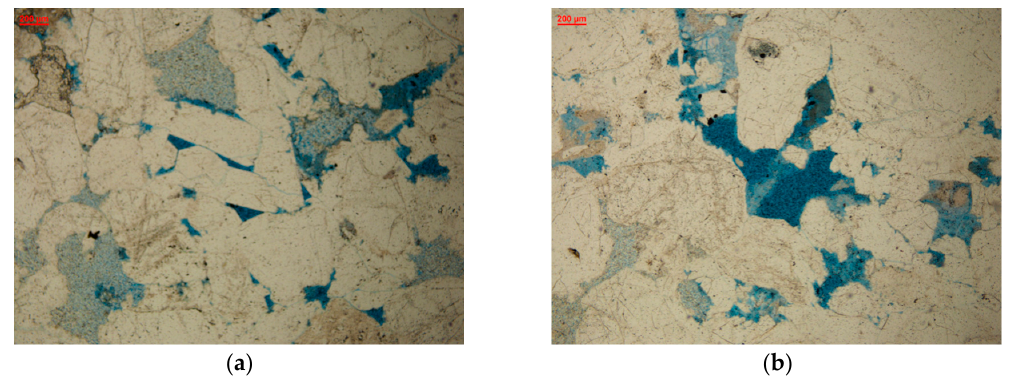
Figure 8. Pore structure illustrated by thin section analysis results of ( a ) core sample #13 and ( b ) core sample #15.